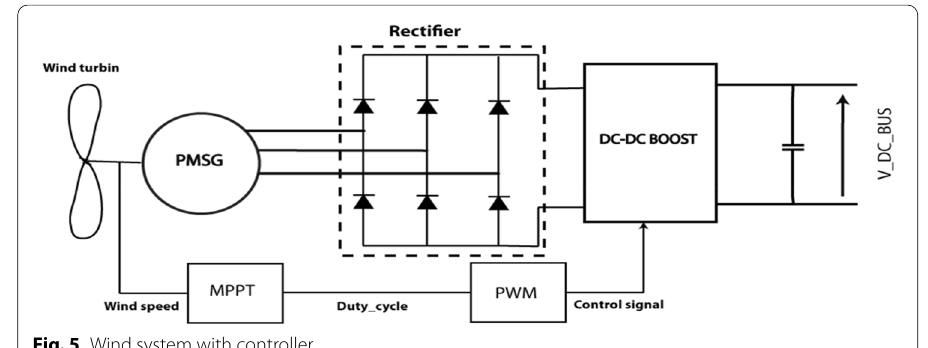
Fig. 5 Wind system with controller